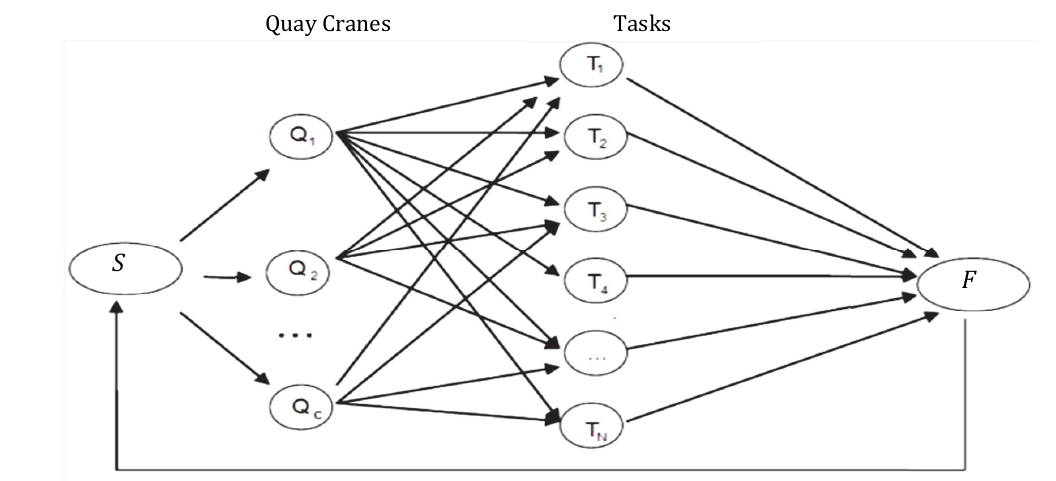
Fig. 3. Proposed Bi-level graph for the displacement of